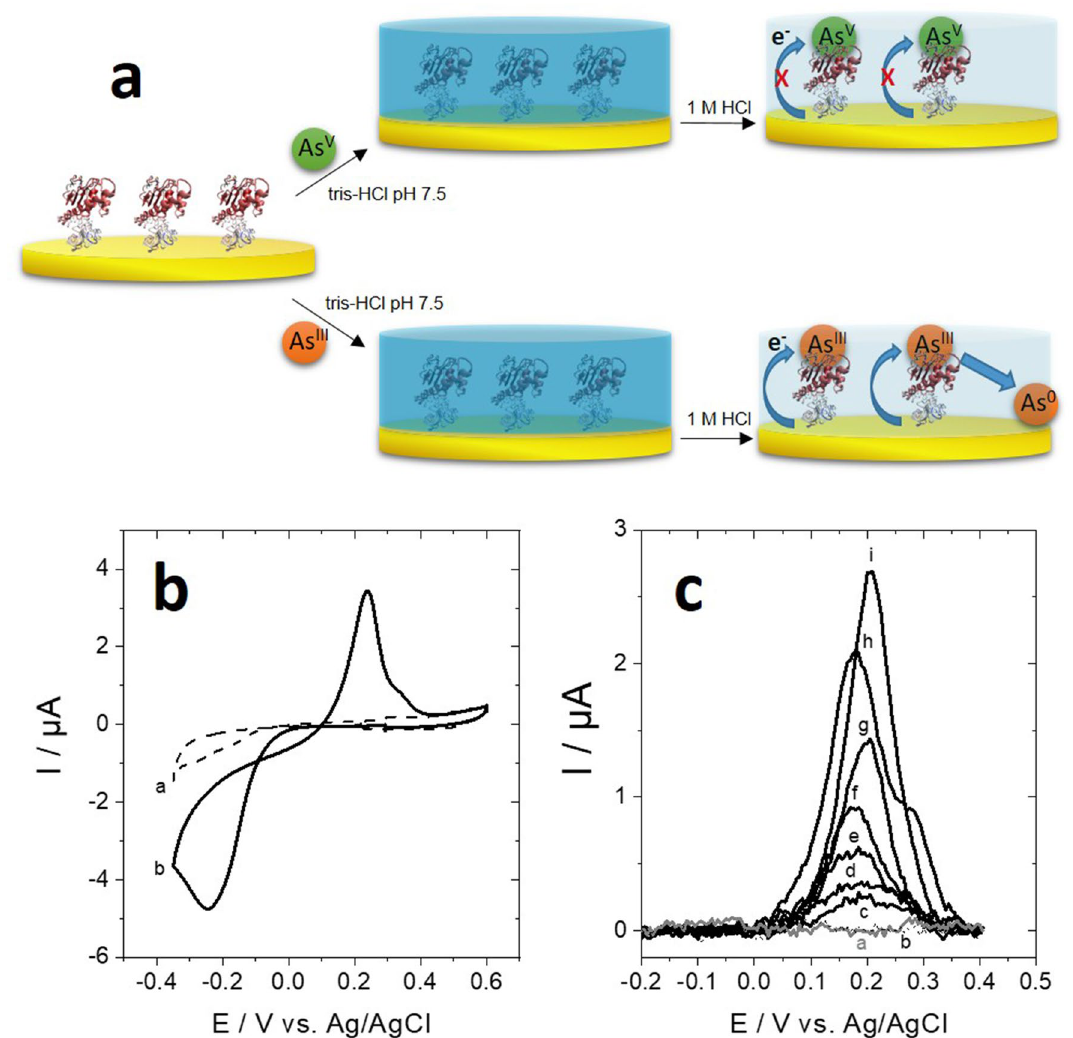
Figure 5. Electrochemical arsenic biosensor. ( a ) Schematic representation of the binding of As(III) and As(V) at Vmh2-ArsC modified gold electrodes. Down: ( b ) CV of the ( a ) nonmodified gold electrode and ( b ) Vmh2- ArsC-modified gold electrodes after incubation (1 h, 60 °C) in solutions of 0.5 mM As(III) and transfer in 1 M HCl, range (− 0.4 to + 0.6) V versus Ag/AgCl, scan rate 10 mV s −1 . ( c ) SWV of the Vmh2-ArsC-modified gold electrodes after incubation (1 h, 60 °C) in solutions of 0.5 mM As(III) for the ( a , gray) nonmodified gold electrode, ( b , dashed line) Vmh2-modified gold electrode and ( c ) 0.1, ( d ) 0.25, ( e ) 0.5, ( f ) 0.75, ( g ) 1, ( h ) 5 and ( i ) 10 mM As(III) for the Vmh2-ArsC-modified gold electrode. SWV parameter: 1 M HCl, pre-deposition at − 0.4 V versus SCE for 5 min, scan rate 100 mV s −1 , f = 50